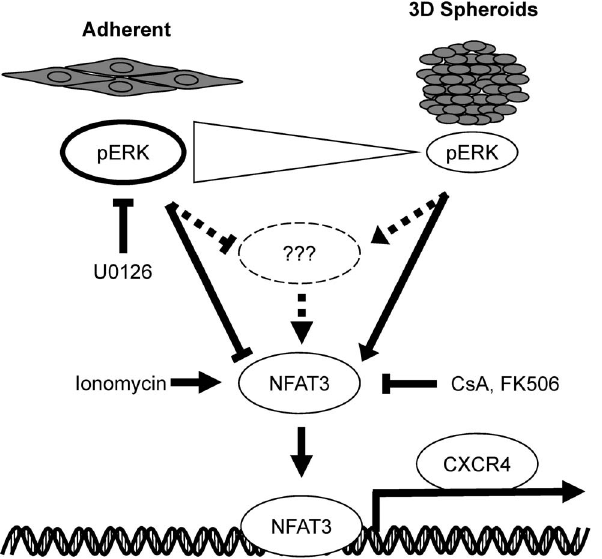
Fig. 9. Model for ERK-NFAT mediated regulation of CXCR4 expression. Our findings suggest that the enhanced phospho-ERK levels in adherent cells prevent NFAT3 mediated CXCR4 up-regulation. The increase in phospho-ERK levels may directly or indirectly inhibit NFAT3 activity but when phospho-ERK levels were decreased through 3D spheroid culturing or treatment with MEK inhibitor U0126, activated NFAT3 transcriptional factor localized to the nucleus and occupied the CXCR4 promoter to activate CXCR4 expression.